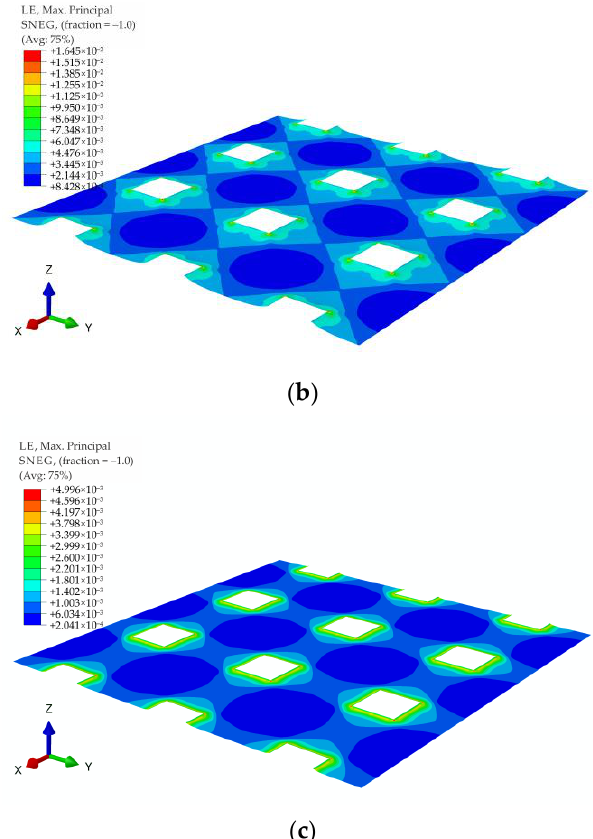
Figure 20. Deformation and maximum principal strain in reinforcement, variant A1: ( a ) k = 10 kN/m 3 ; ( b ) k = 150 kN/m 3 ; ( c ) k = 500 kN/m 3 .